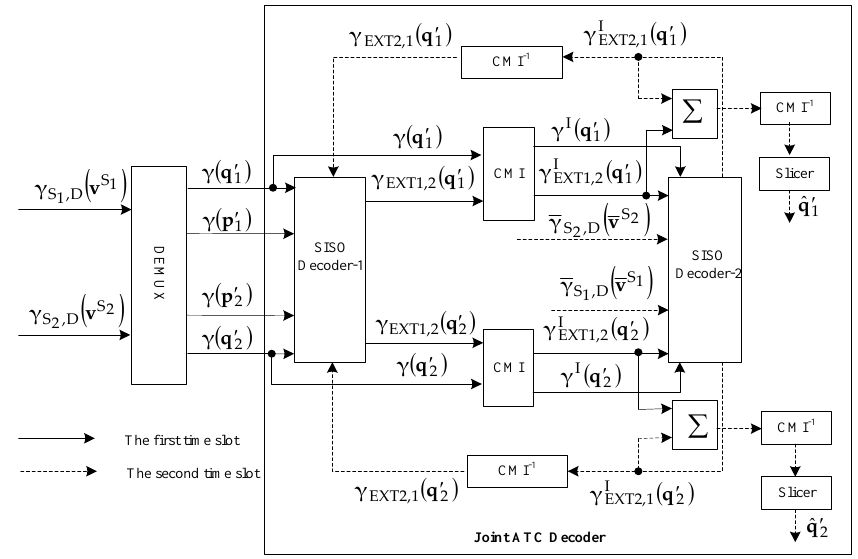
Figure 8. Joint iterative ATC decoder.